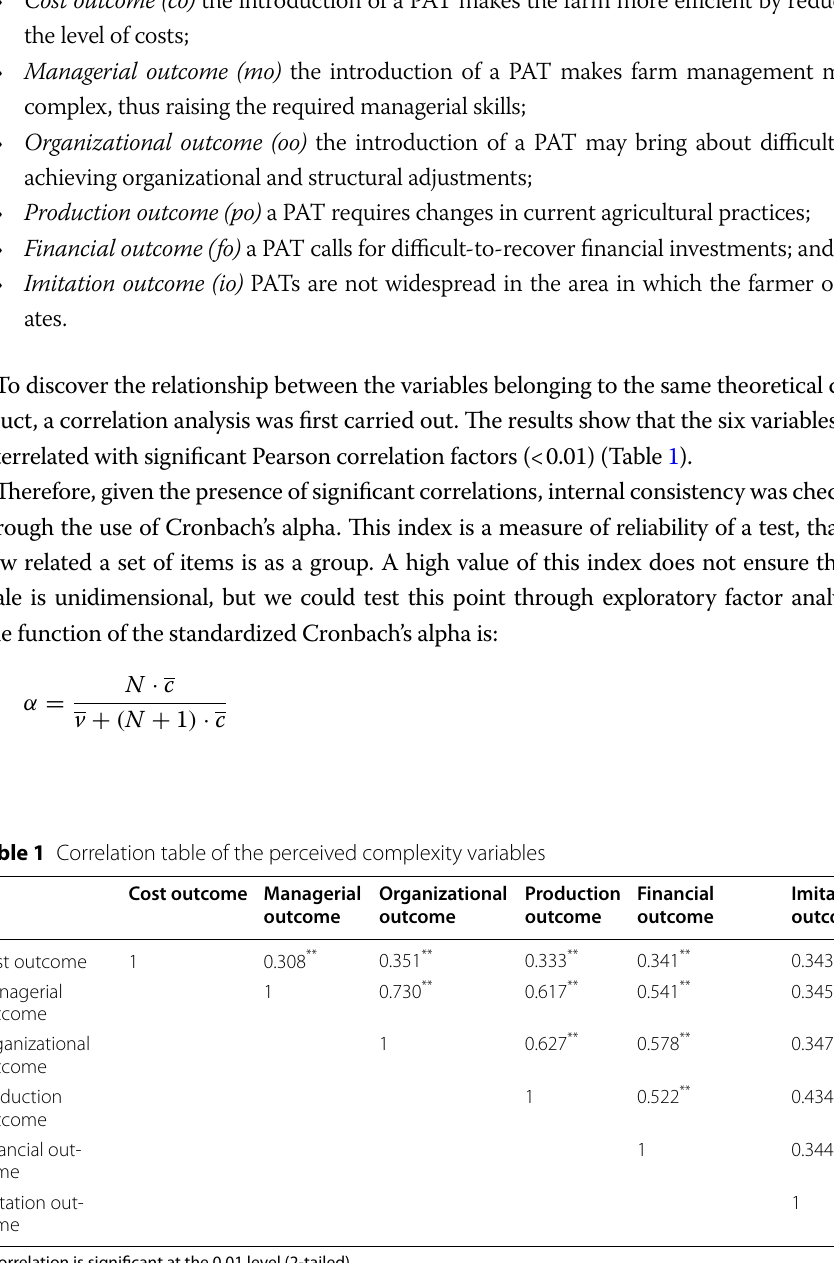
** Correlation is significant at the 0.01 level